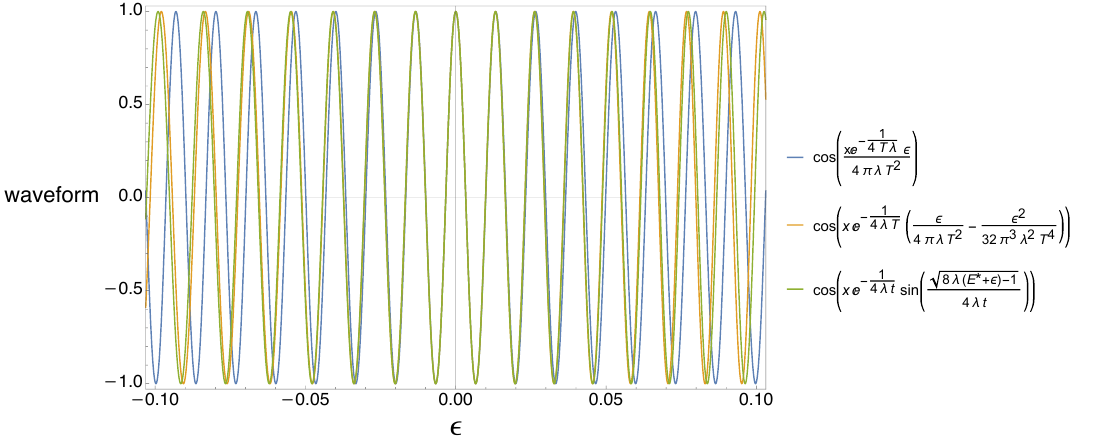
Figure 16. We show the comparison between the plots of the original waveform (green) and its first-order (blue) and second order (green) approximations in (cid:15) , where λ = − 1 / 10 , T = 1 / 2 , x = 1 (again, to make his figure visually discernible, a small x is chosen). We see that the first-order one clearly deviates from the other two